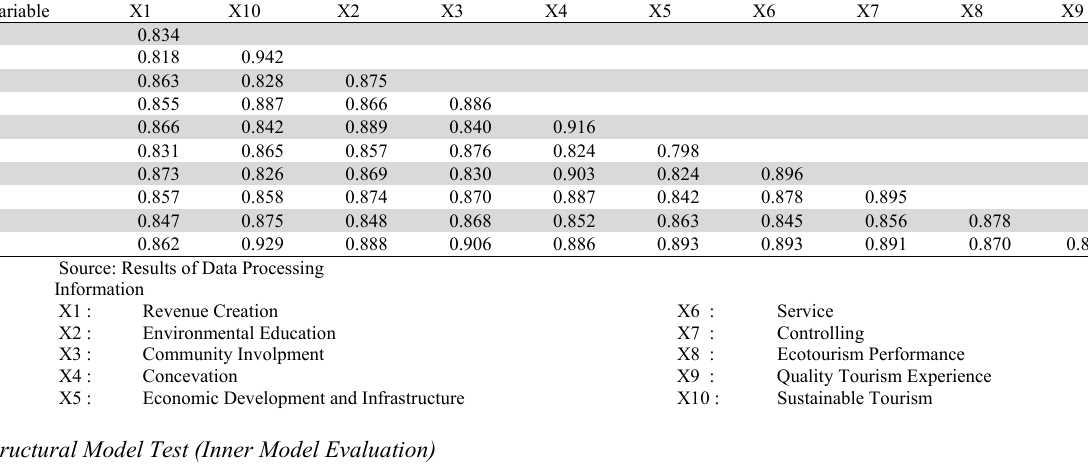
Discriminant Validity (Fornell-Larcker Criterion) Variable